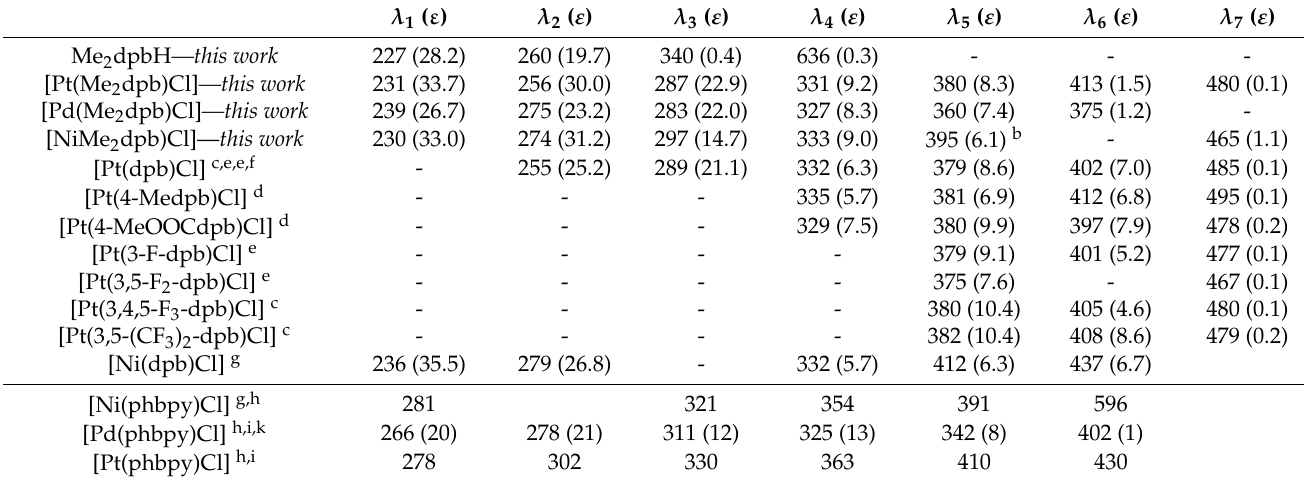
Figure 3. UV-vis absorption spectra of Me 2 dpbH and the complexes [M(Me 2 dpb)Cl] in CH 2 Cl 2 solution ( A ) and TD-DFT- calculated spectra ( B ) (TPSSh/def2-TZVP level of theory). The yellow (Pd), orange (Pt), and red (Ni) colour code refer to the colours of the compounds. Table 2. Selected UV-vis absorption maxima of Me 2 dpbH, the complexes [M(Me 2 dpb)Cl], and related derivatives a .